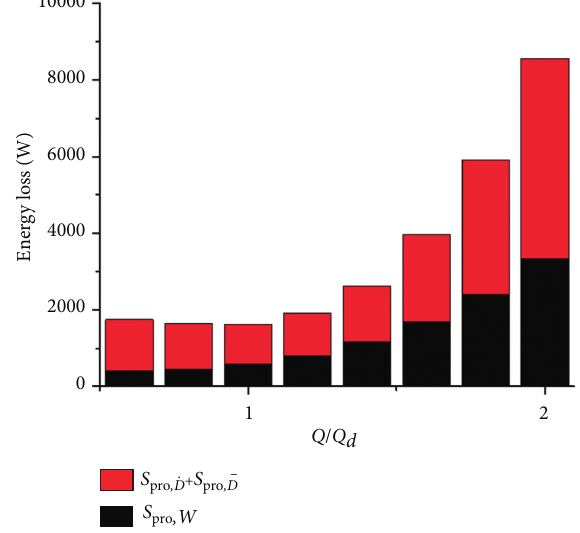
Figure 7: Total entropy production and wall loss under different flow